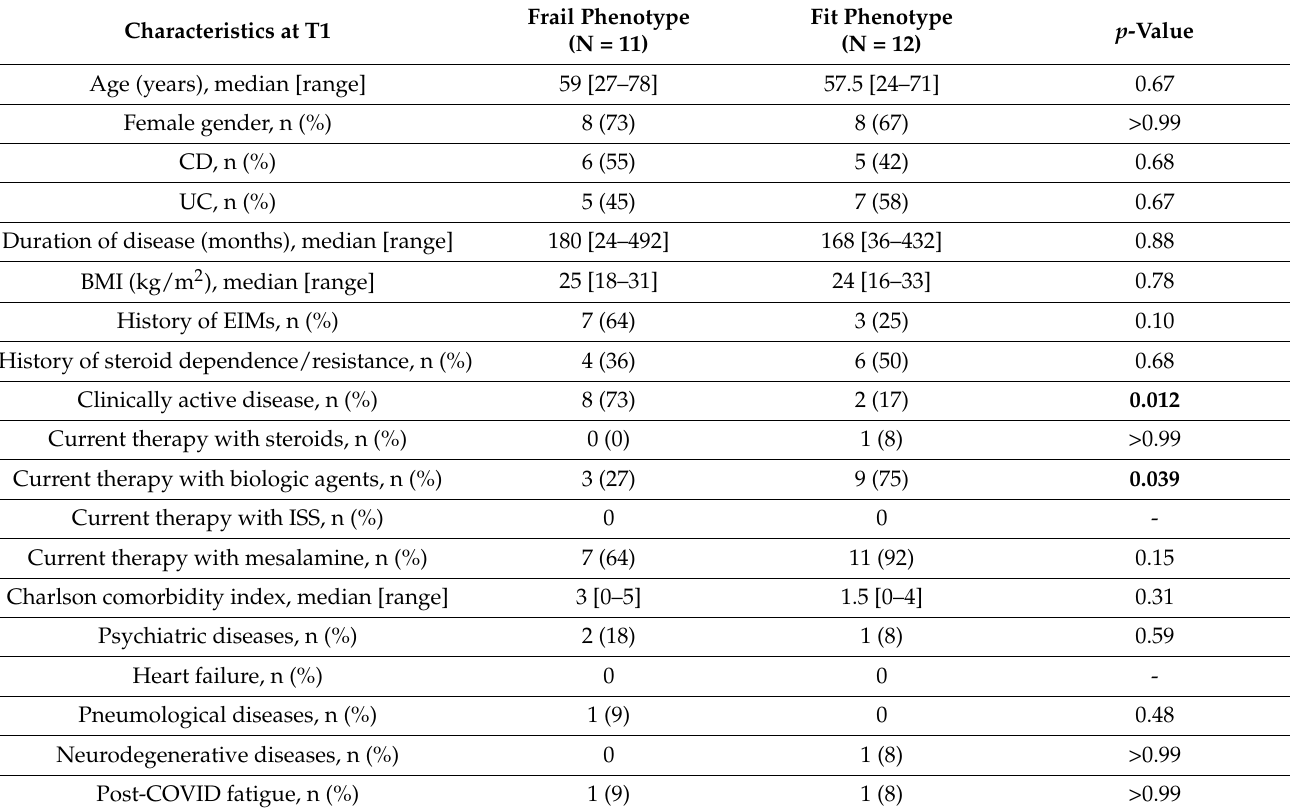
Table 2. Demographic and clinical characteristics of patients with frail phenotype compared to patients with fit phenotype at the end of the study (T1). CD: Crohn’s disease; UC: ulcerative colitis; BMI: body mass index; EIMs: extraintestinal manifestations; ISS: immunosuppressors.